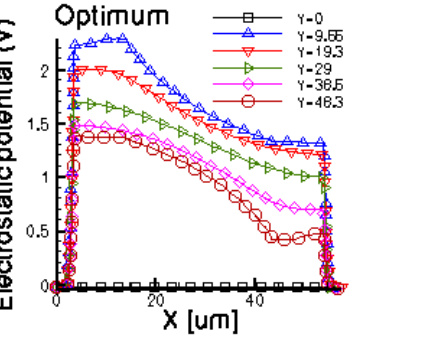
Figure 15. Electrostatic potential (V) in orthogonal cuts on Oy and Ox for optimum and borderless